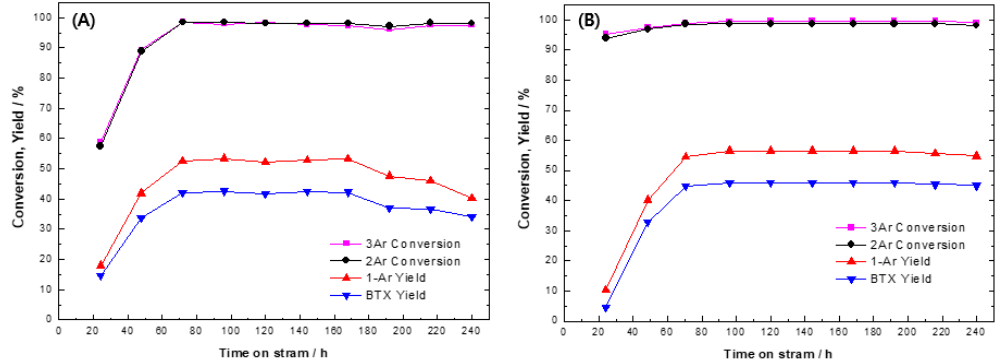
Figure 6. HCK performances for pyrolysis fuel oil (PFO) over Ni 2 P / β ( A ) and Ni 2 P / DS- β ( B ) at 653 K and 6.0 MPa.